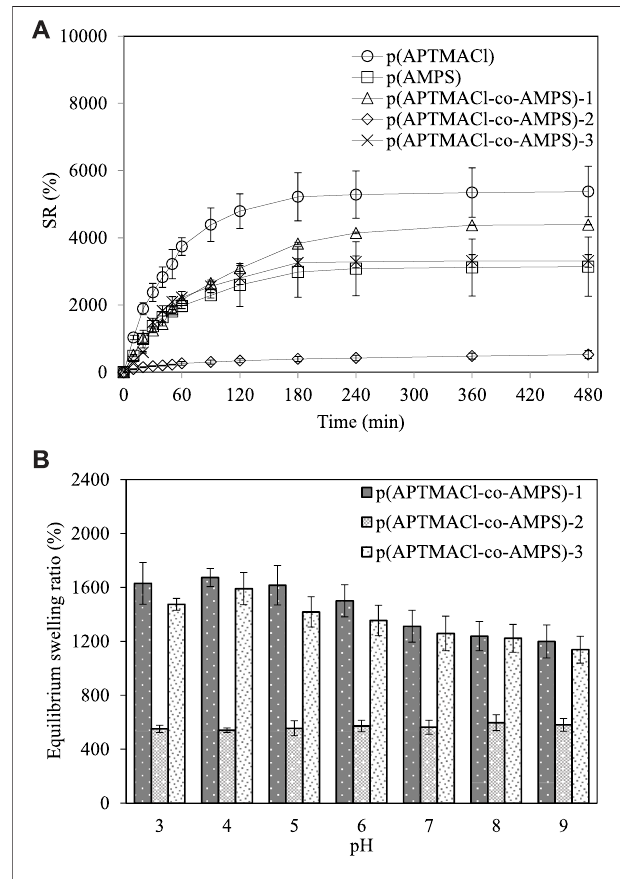
FIGURE 3 | (A) The swelling Ratio (SR%) of p (APTMACl), p (AMPS), p (APTMACl-co-AMPS)-1, p (APTMACl-co-AMPS)-2, and p (APTMACl-co- AMPS)-3 hydrogels with time, and (B) the equilibrium swelling % of p (APTMACl-co-AMPS)-1, p (APTMACl-co-AMPS)-2, and p (APTMACl- co-AMPS)-3 hydrogels at equilibrium time from pH 3.0 to